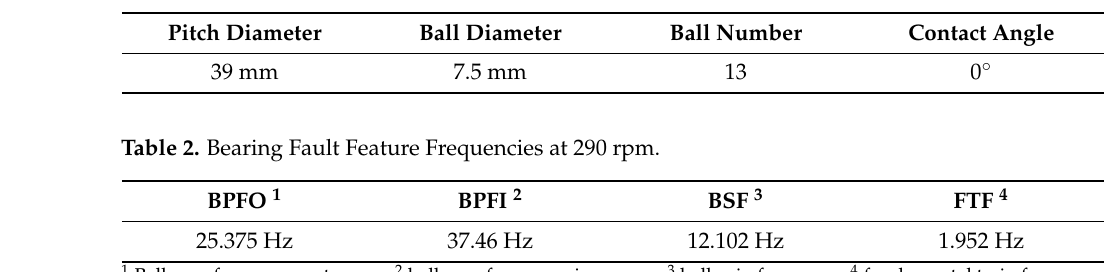
Figure 4. Bearing fault conditions: ( a ) outer race fault; ( b ) inner race fault; ( c ) roller fault. Table 1. Bearing Configuration.